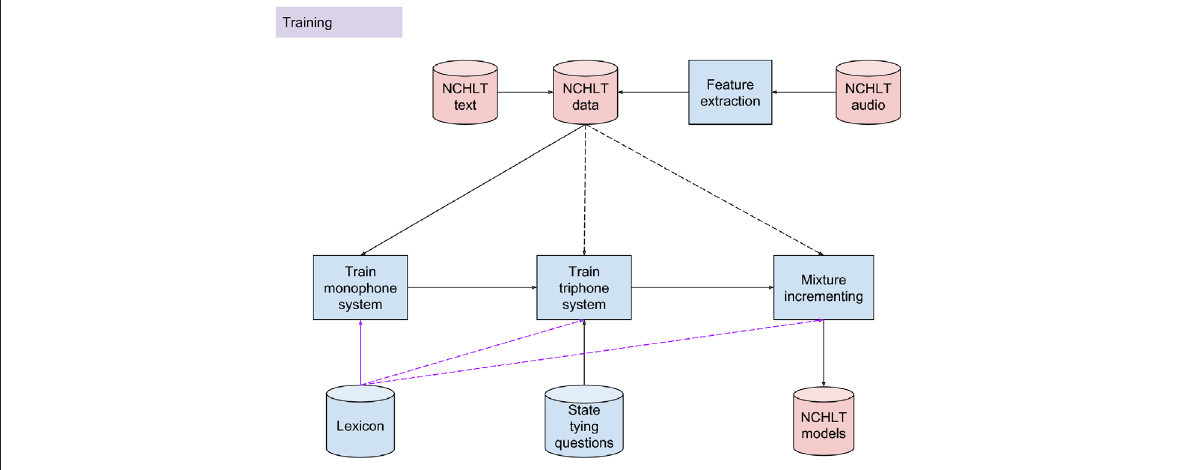
Figure 1: Baseline National Centre for Human Language Technology (NCHLT) training scheme.